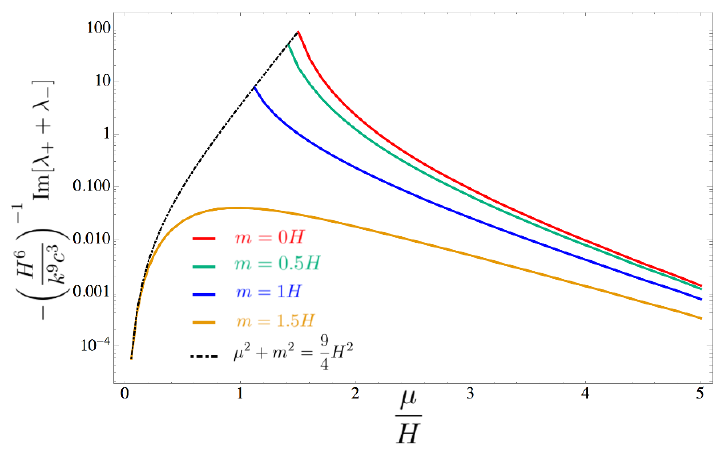
Figure 10 . The coe(cid:14)cients of the cosine term in equation (6.12) for m = 0, 0 : 5 H , H , and 1 : 5 H .